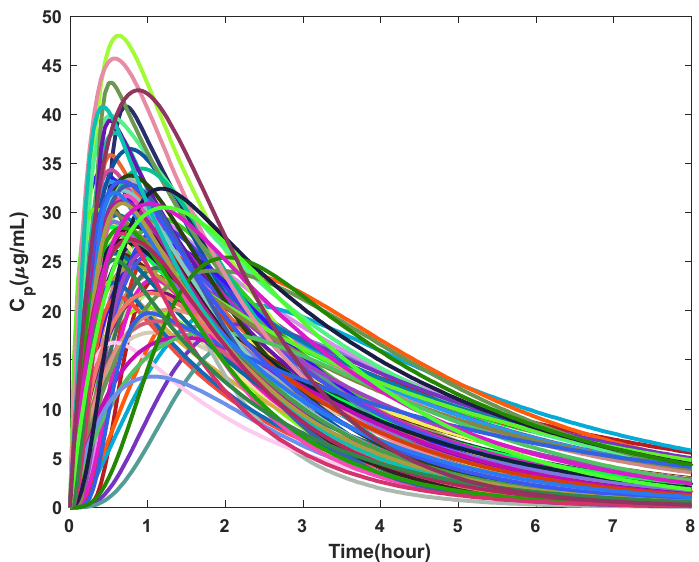
Figure 9. Pharmacokinetic plots for 87 participants with every color marking an individual partici- pant.